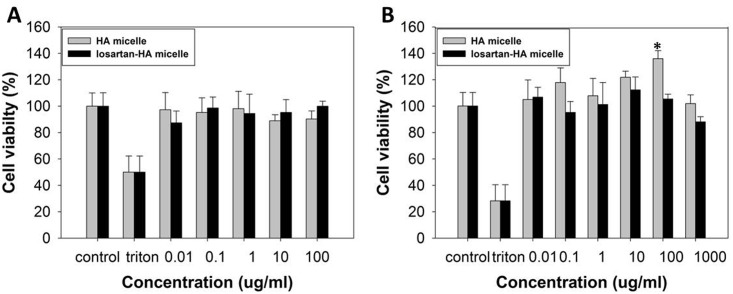

In vitro cytocompatibiliy of HA micelle and losartan-HA micelle (in PBS, pH 7.4).
A. hHSC; B. FL83B cell line. MTS assay of HA micelle and losartan-HA micelle has minimum toxicity effect even at high concentration (100 and 1,000 μg/ml). MTS assay data show the mean cell viability of quadruplicate samples ± SD. Losartan-HA micelle at 100 μg/ml showed significantly higher cell viability (*P <0.01) relative to the control in FL83B cell line. All other treatment does not show significant change in cell viability compared to control in both hHSC and FL83B cell lines (P>0.05).